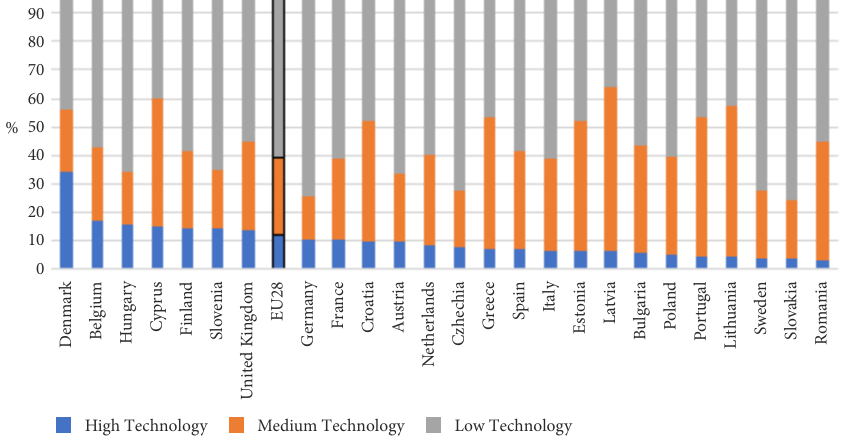
(source: author computation based on Eurostat, 2021)